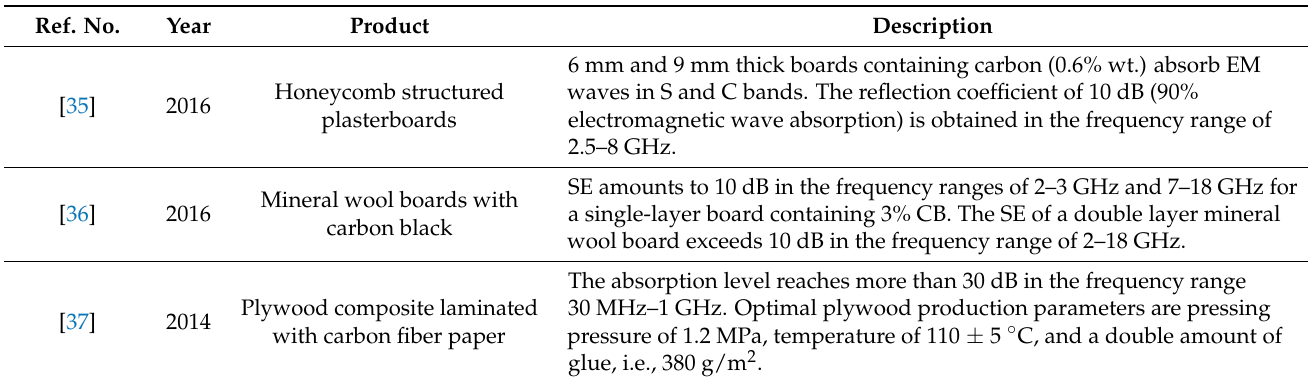
Table 1. Summary of the products described in Section